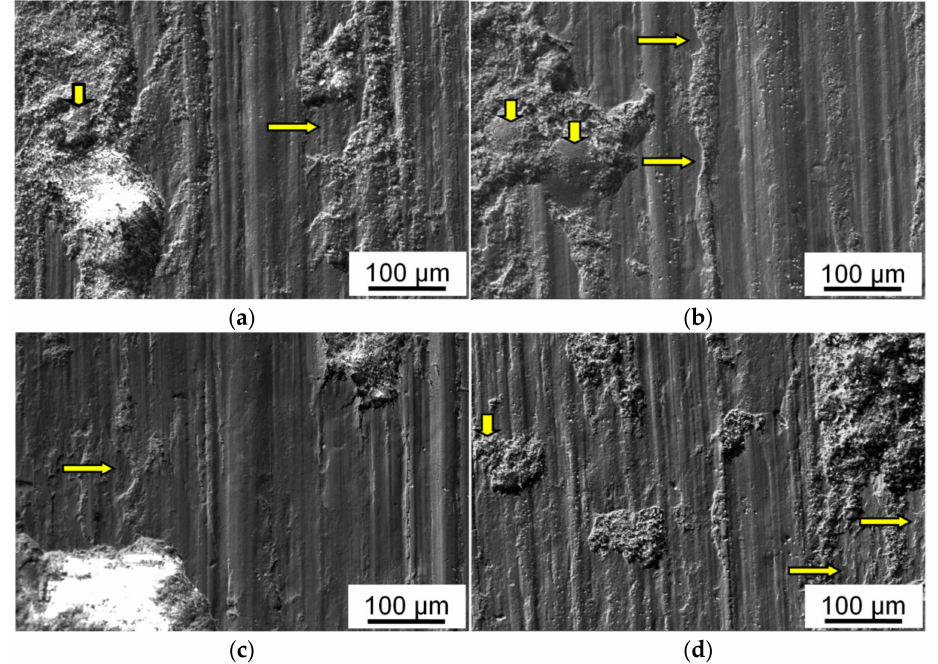
Figure 6. SEM images of the friction surface of HP-ed (Al–10Zn)–40Sn composite sample after dry friction against steel at high ( P = 5 MPa) ( a – c ) and low ( P = 1 MPa) ( d ) pressures. V , m/s: 0.9 ( a ); 0.3 ( b ); 0.6 ( c , d ). Areas of delamination of wear particles are shown by horizontal arrows, and delaminated particles pressed into the friction surface are shown by vertical